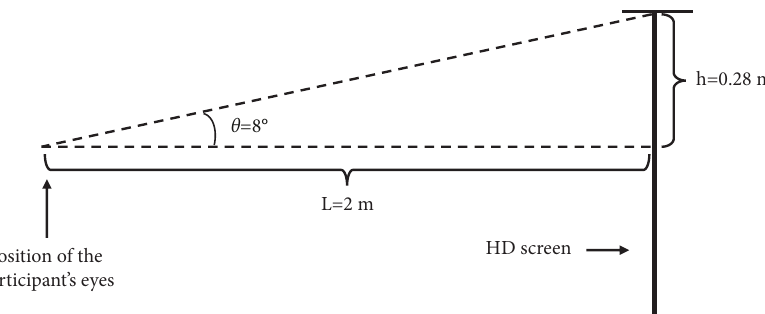
Figure 3: Illustration of the key parameters of the experimental condition.